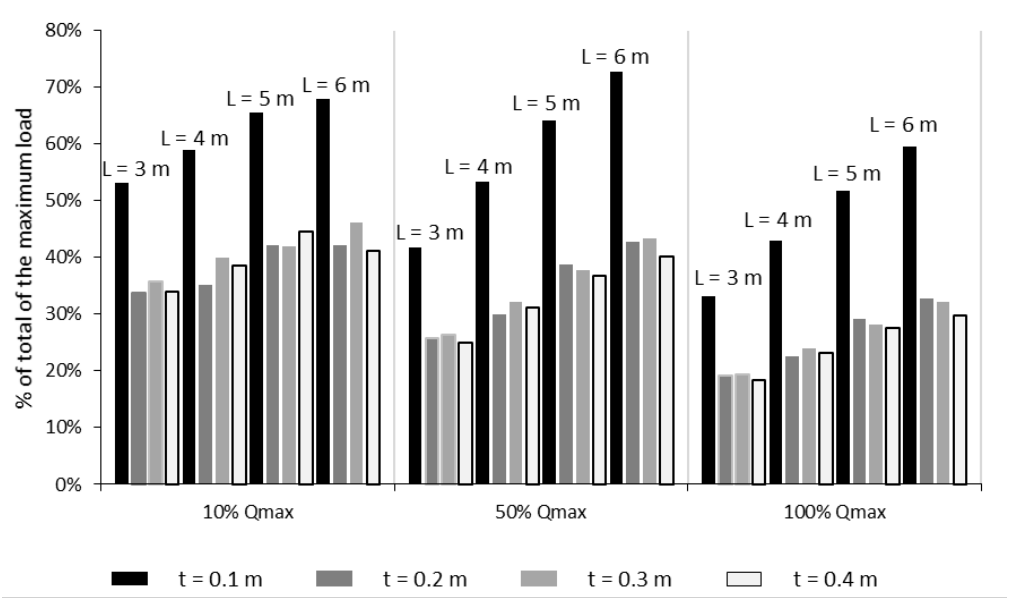
Figure 24. Portion of the maximum load taken by the total shaft